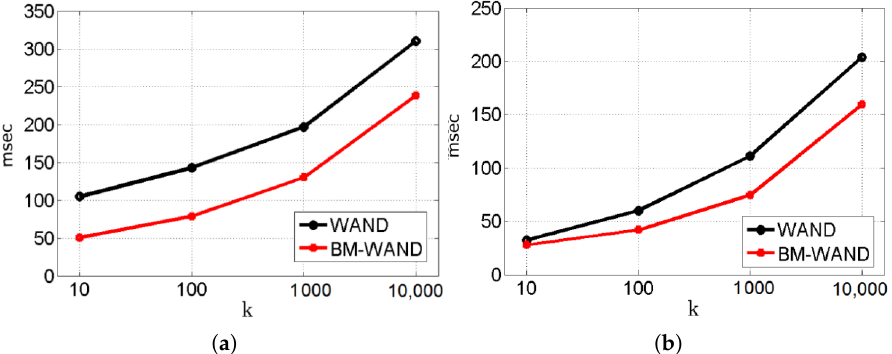
Figure 2. Average execution time in milliseconds (ms) reported by the WAND and the BM-WAND algorithms with the ( a ) ClueWeb09 and the ( b ) Gov2 Web